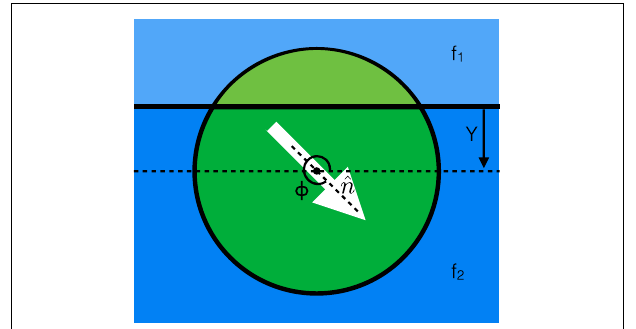
FIGURE 1 | View from above showing the two regions: one above (light green) and the other below (dark green), the interface between two different substrates shown in light and dark blue, respectively . Each region of the cluster propels itself along the polarization direction ( ^ n at an angle of (cid:8) with the positive x -axis) with a force per unit area of f 1 for the top region and f 2 for the bottom region. The cluster center is at a height Y above the interface (in the diagram shown, Y is negative because the center of the cluster is below the